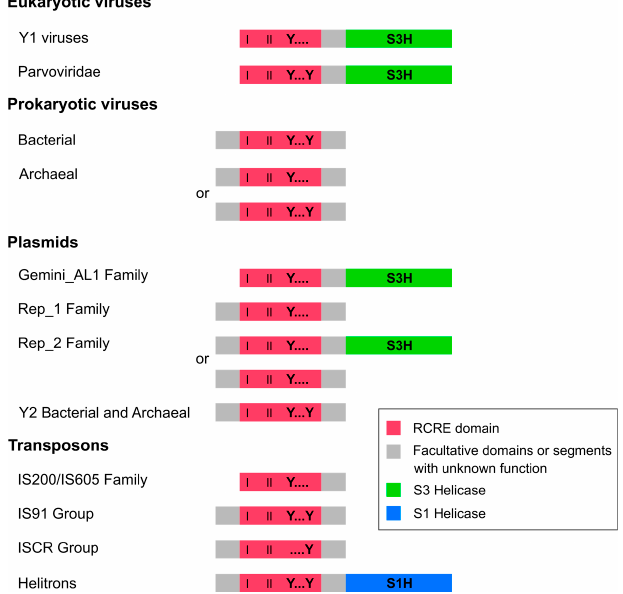
Figure 1. Modular diversity of HUH endonucleases. Schematic representation of the rolling-circle replication (RCR) proteins included in the present analysis. Rolling-circle replication endonuclease (RCRE) domains have the first two motifs (I and II), in addition to the third motif represented by one or two tyrosines (Y) in the catalytic core (dots represent variable amino acid residues). Domains are not drawn to scale, and segments after helicase domains are not represented. Based on information from Chandler et al. [1], Koonin and Dolja [8], and the Conserved Domain Database (CDD) search tool